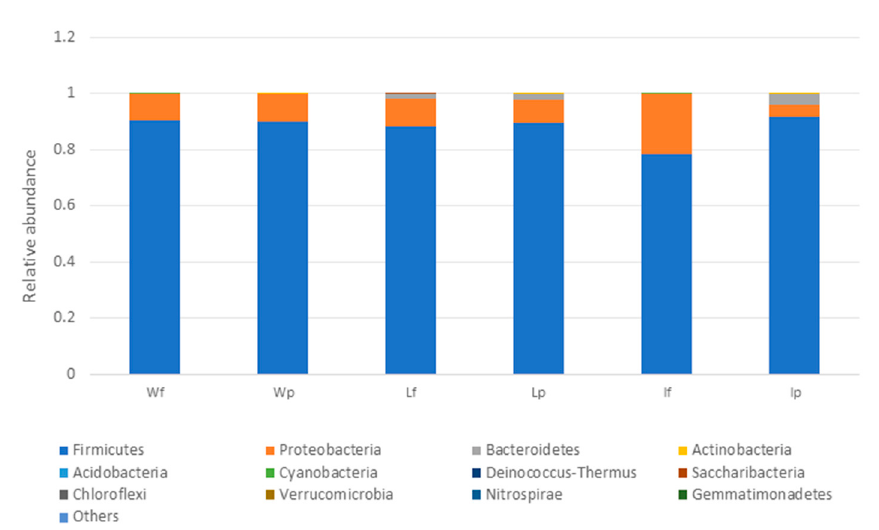
Figure 6. Relative abundance profiles of meat samples (at the phylum level) with Lf, If and Wf representing the unprocessed local meat, unprocessed imported meat and unprocessed wet market meat, respectively. LP, Ip and Wp represent the processed local meat, processed imported meat and processed wet market meat, respectively.